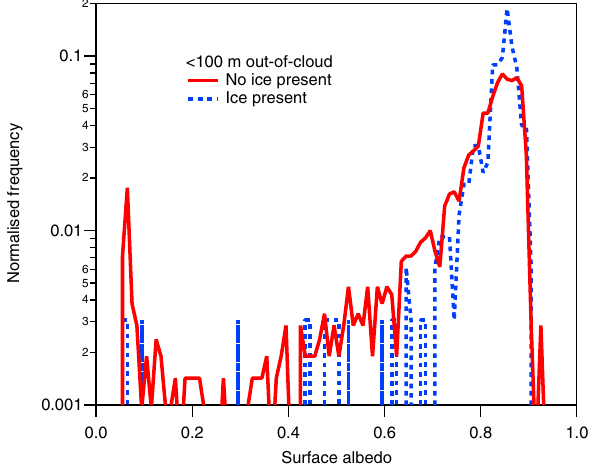
Figure 14. Frequency plots of the surface albedo for of out-of-cloud measurements (below 100m) when there was (blue line) and was not (red line) ice